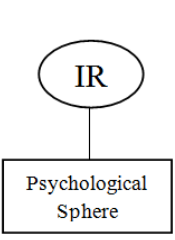
Figure 4. Correlation relationships of the indicator “IR” of the teachers’ group 1 Note: correlation at a significance level of